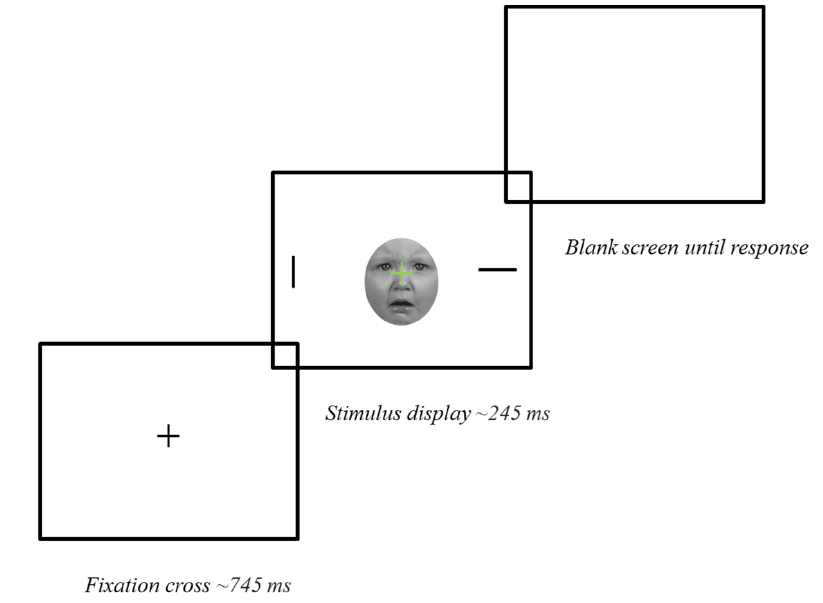
Figure 1. An example of a trial structure and screen presentation sequence. Each trial begins with a central fixation cross (745 ms). The stimulus display (245 ms) consists of an infant or adult face shown behind the central green or red cross, and two-line targets (one horizonal, one vertical) presented peripherally. The screen response (blank screen) is aborted if no response is registered within 2000 ms.